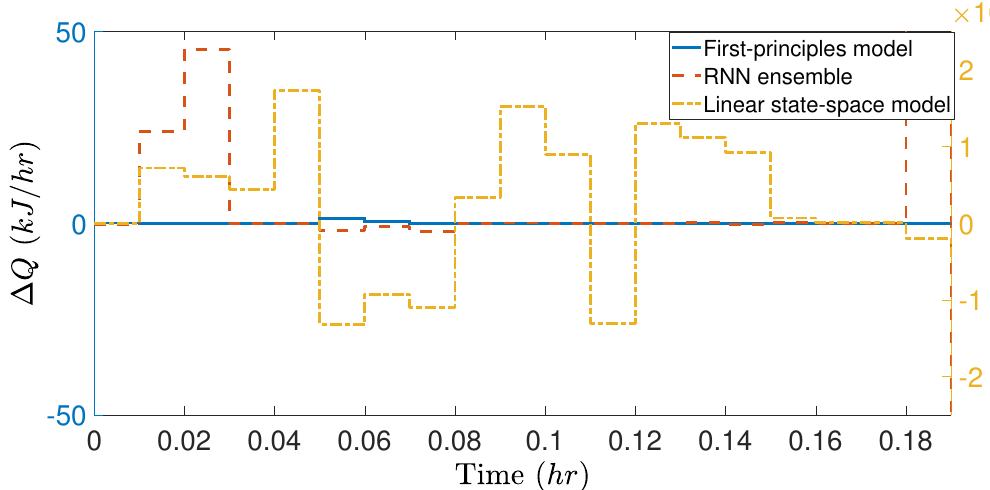
Figure 8. Manipulated input profiles ( u 2 = ∆ Q ) for the initial condition (0, 0) under the LEMPC using the following models: the first-principles model (blue trajectory corresponding to left y -axis), the RNN model ensemble (red trajectory corresponding to left y -axis) and the linear state-space model (yellow trajectory corresponding to right y − axis